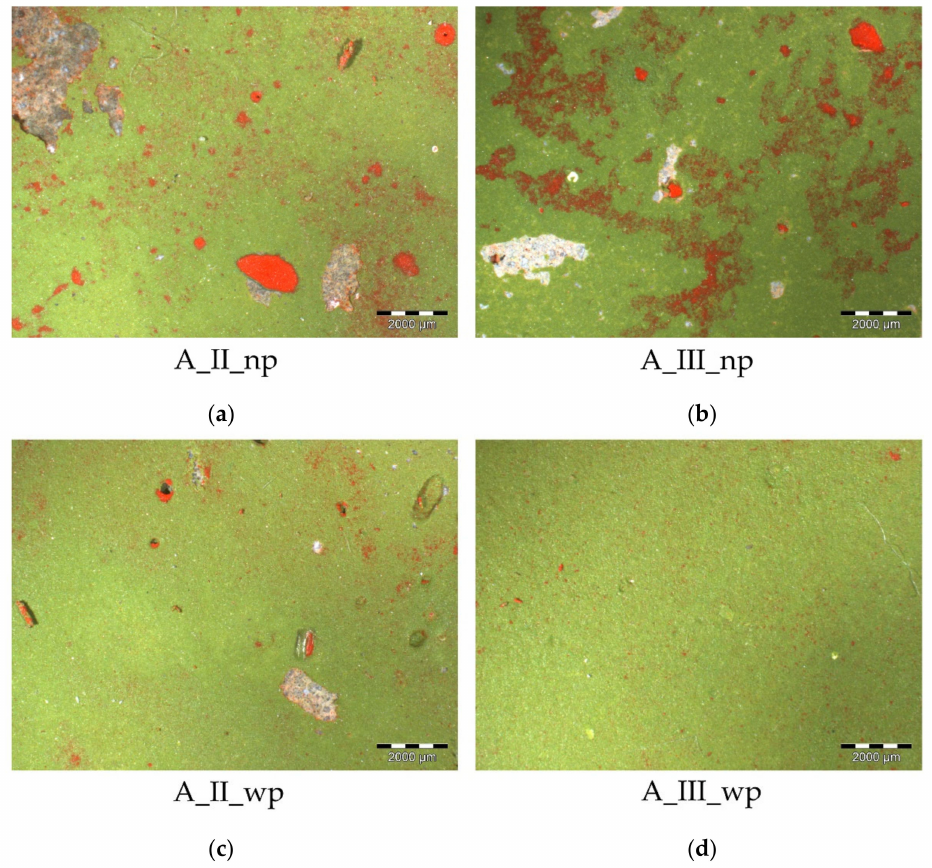
Figure 2. Optical images at 10 × of mock-up A treated with agar gel with ethanol ( a , c ) and with Nanorestore Gel ® with a solution of Polar Coating S ® in 9% Ethyl acetate for 1 h ( b , d ) on both unprotected (np) and protected (wp) areas. ( a ) A_II_np; ( b ) A_III_np; ( c ) A_II_wp; ( d )